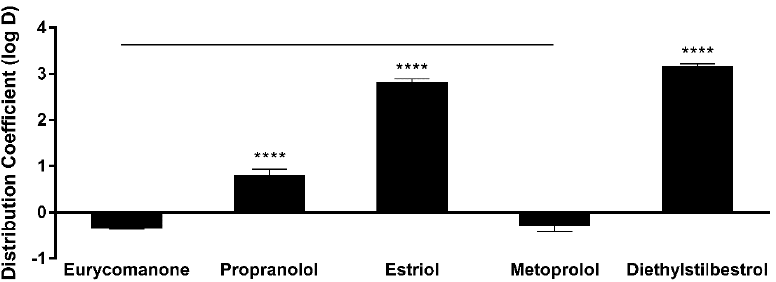
Figure 4. Lipophilicity properties of eurycomanone, propranolol, estriol, metoprolol, and diesthylstilbestrol. The distribution coefficient (log D) value for eurycomanone was − 0.35. All standards showed acceptable log D values, respectively. The values were plotted based on the mean ± standard deviation. **** denotes significant difference when compared to eurycomanone ( p ≤ 0.0001). The log D value of eurycomanone is comparable to that of metoprolol. Line over bars indicates no significant difference between metoprolol and eurycomanone ( p ≥ 0.05).